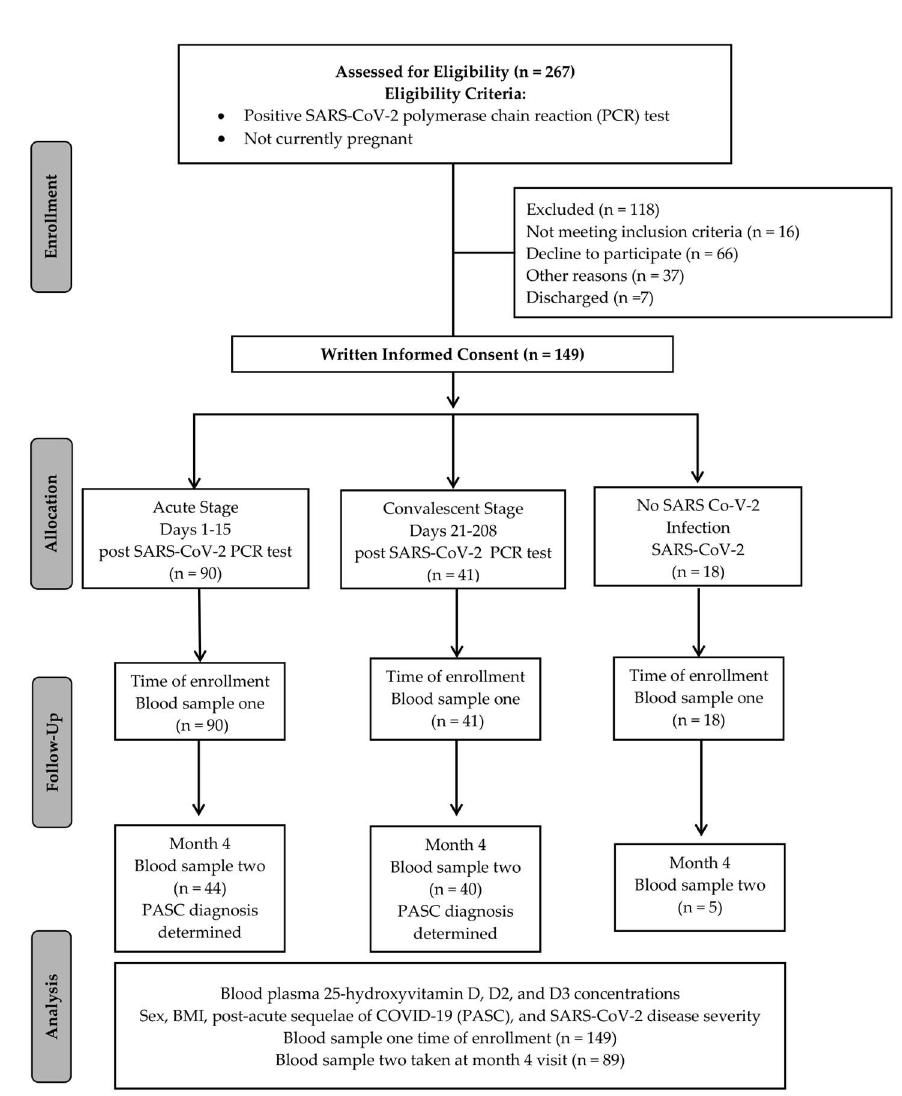
Figure 1. Study design for plasma total 25(OH)D and D3 analysis from 131 adults diagnosed with COVID-19 and 18 adults with no COVID-19 diagnosis. The plasma total 25(OH)D and D3 concentra- tions were analyzed for statistical comparison between adults with and without COVID-19 and for comparison from time of enrollment and after 4 months.